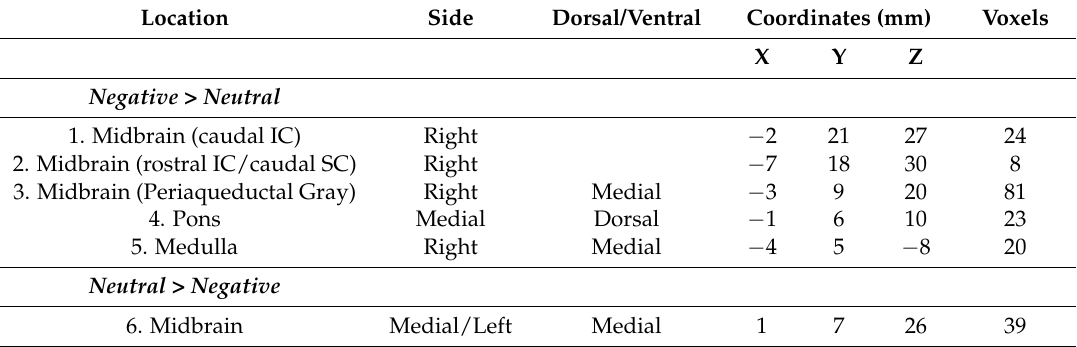
Table 1. Location of brainstem activity in the contrast of the negative sounds and neutral